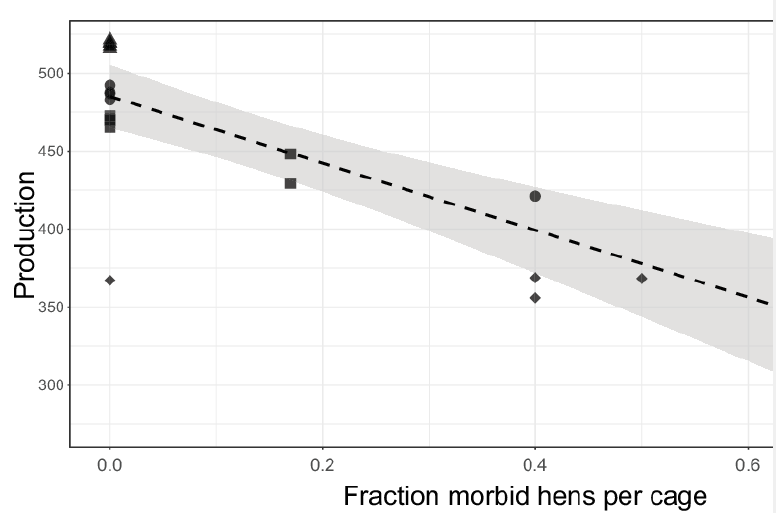
Figure 3. Corrected means of production per cage. The x-axis depicts the fraction of morbid hens per cage, whereas the y-axis depicts the production. The different (post hoc) groups are depicted by a triangle (PROD-hi), a diamond (PROD-Lo), a square (BS-Hi), or a circle (BS-Lo). The dotted line represents the linear regression and the gray area depicts the associated standard error.